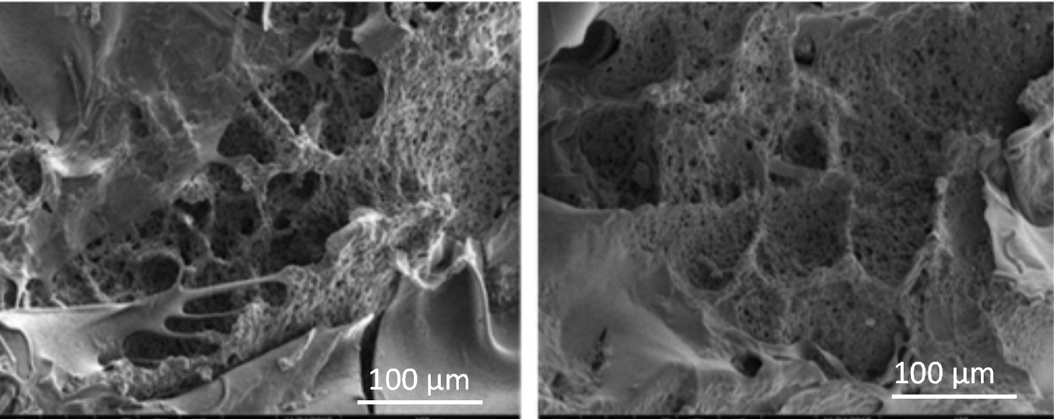
Figure 3. SEM micrographs of p(HEMA-co-AGE) cryogels.